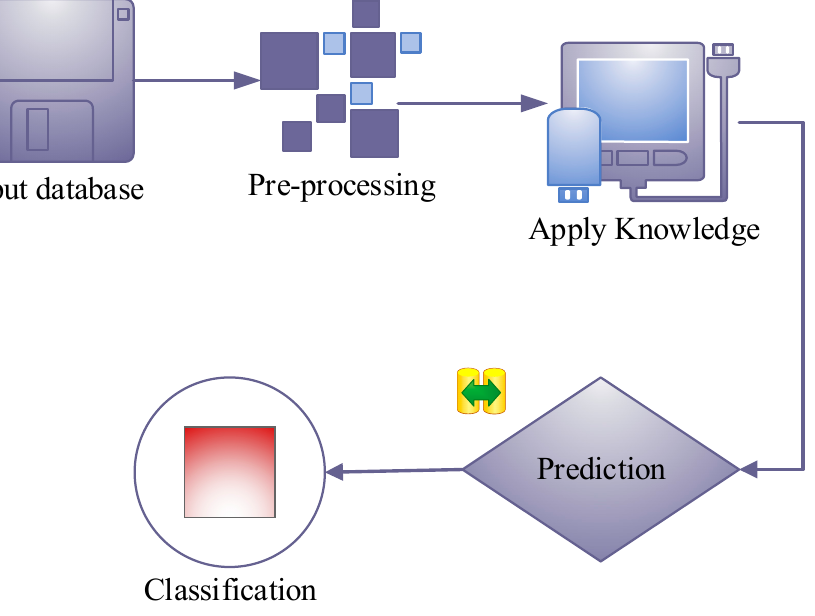
Figure 2. Fundamentals of detection and prediction of